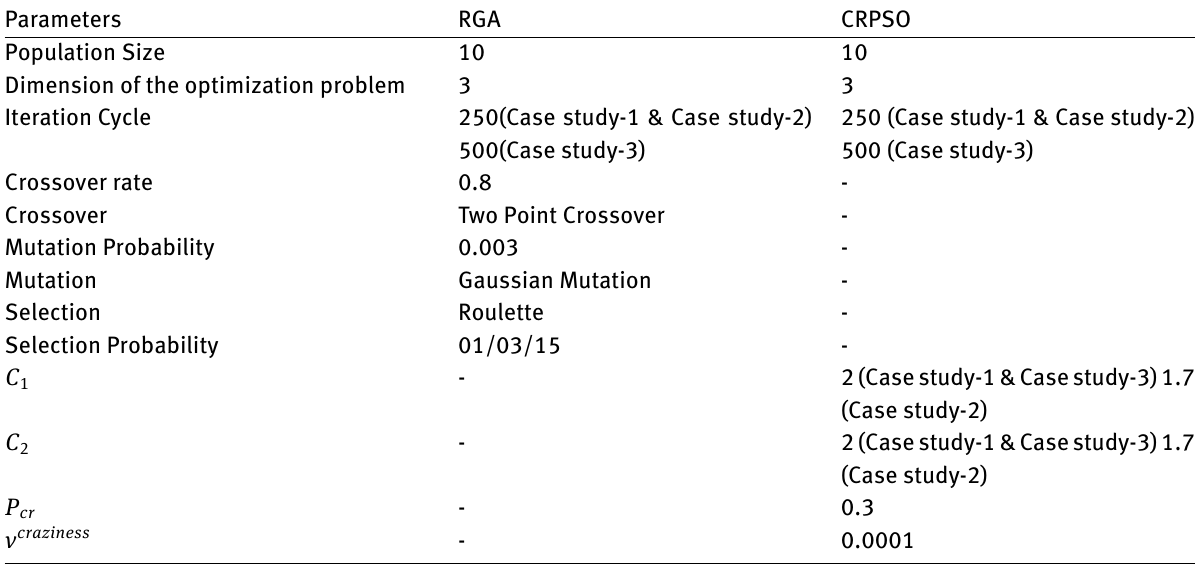
Table 1: RGA and CRPSO parameters for different Case studies. Parameters